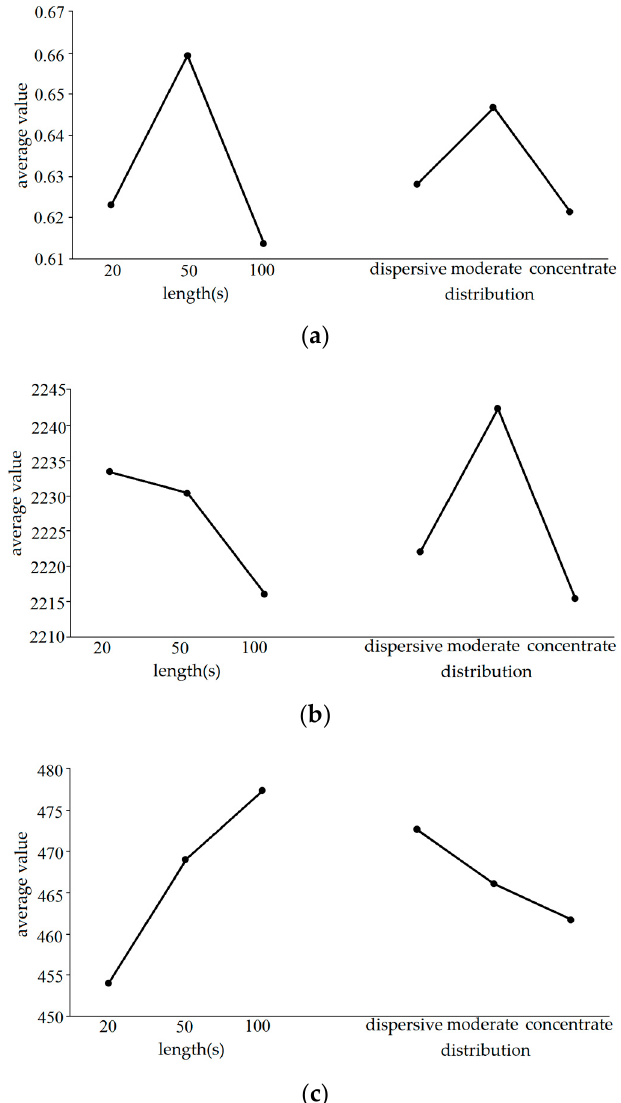
Figure 14. Analysis of extreme differences in different objective function values at different factor levels. ( a ). Analysis of extreme differences in F1 function values at different levels; ( b ). analysis of extreme differences in F2 function values at different levels; ( c ). analysis of extreme differences in F3 function values at different levels.